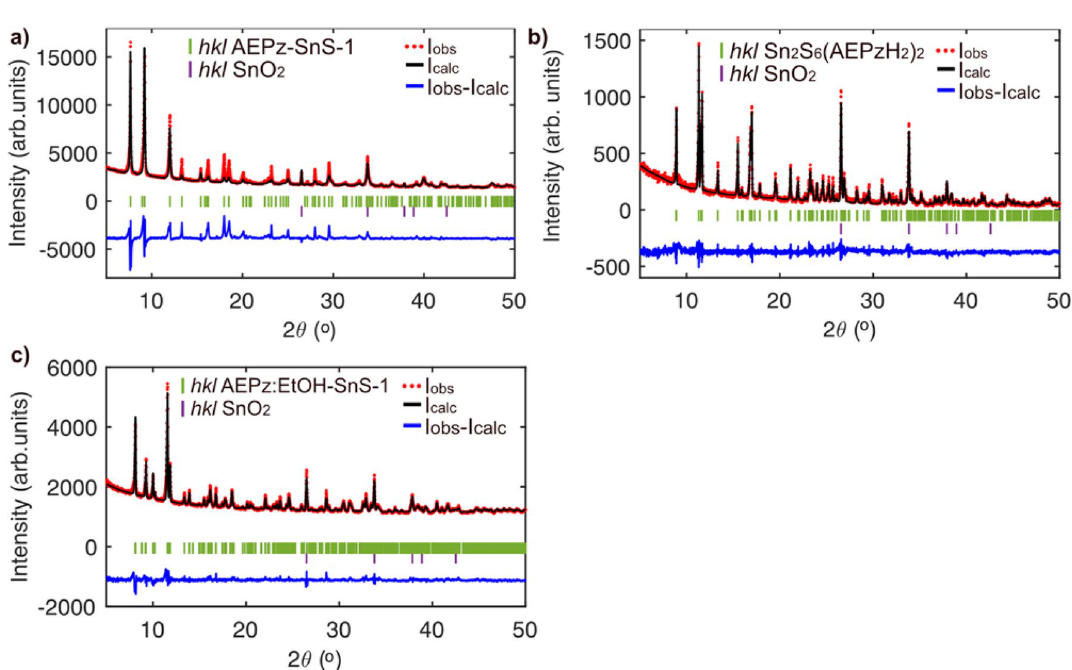
Figure 3. Rietveld refinement of PXRD data for ( a ) AEPz-SnS-1, ( b ) Sn 2 S 6 (AEPzH 2 ) 2 , and ( c ) AEPz:EtOH- SnS-1. Structural models for the thiostannates were obtained from structure solutions based on single crystal diffraction (this paper), while CIF data for SnO 2 was obtained from ICSD entry 9163 37 . See refinement details in Table S2, S3 and